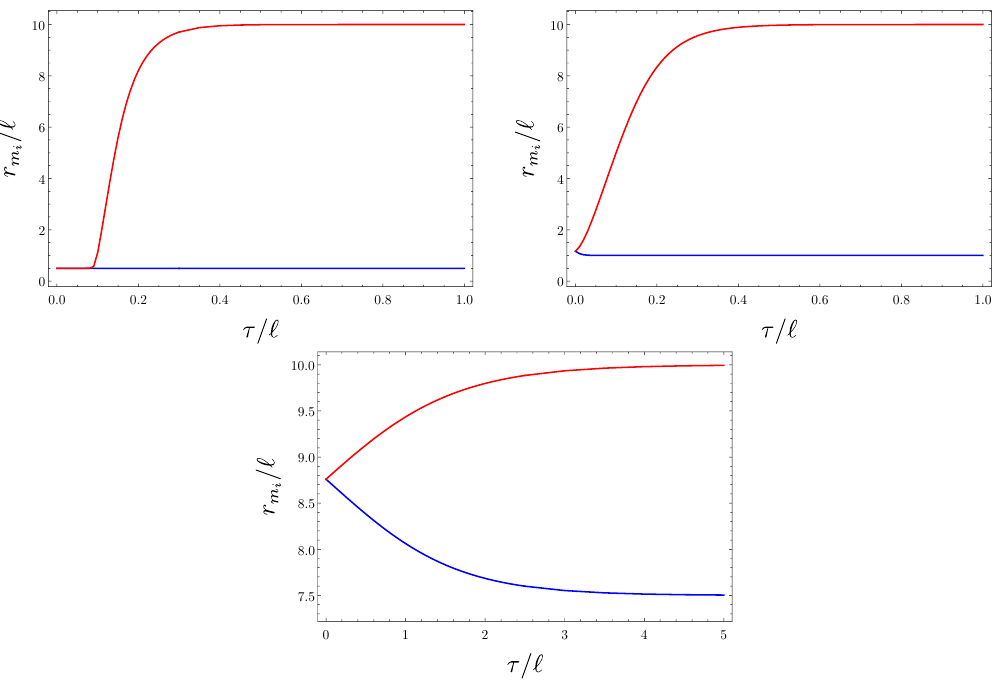
(blue) and r m (red) as a function of time. In each plot we 1 2